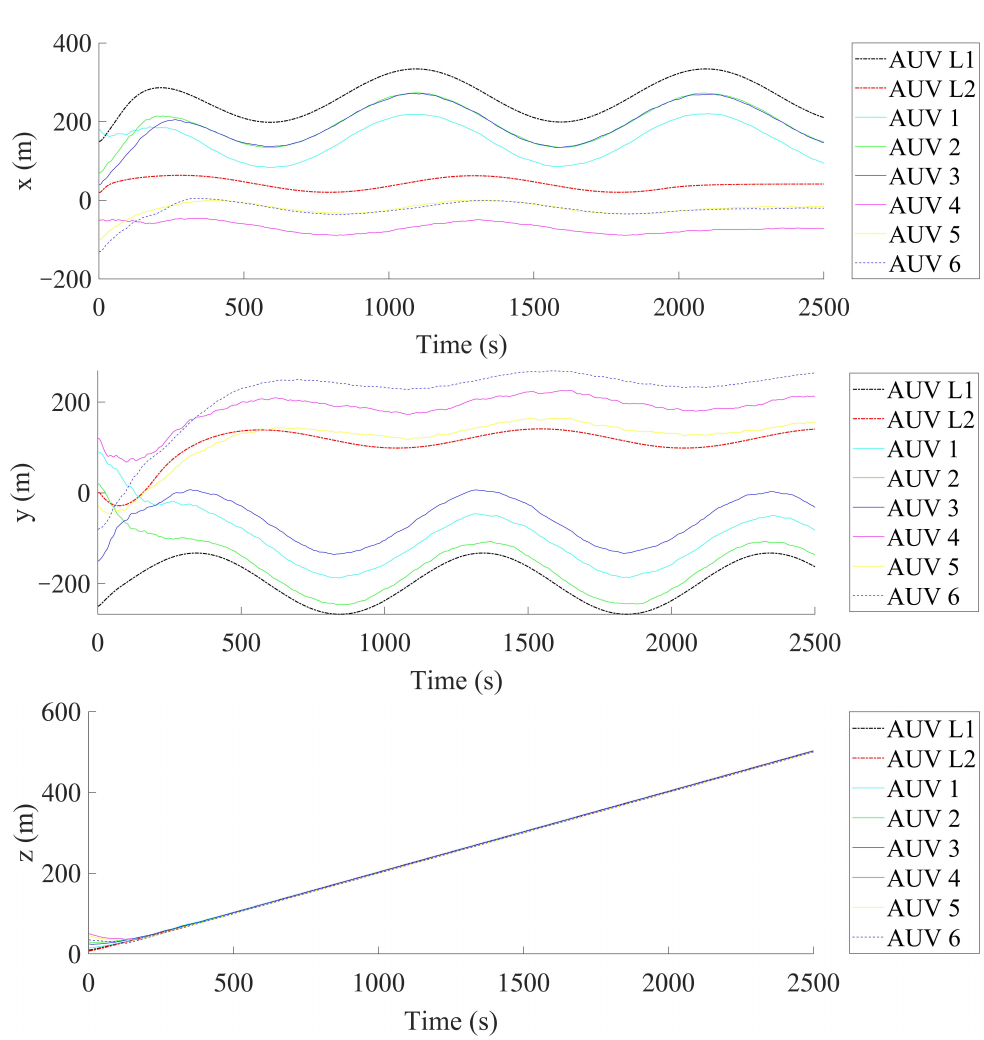
Figure 7. The position states of a multiple stochastic AUV system.